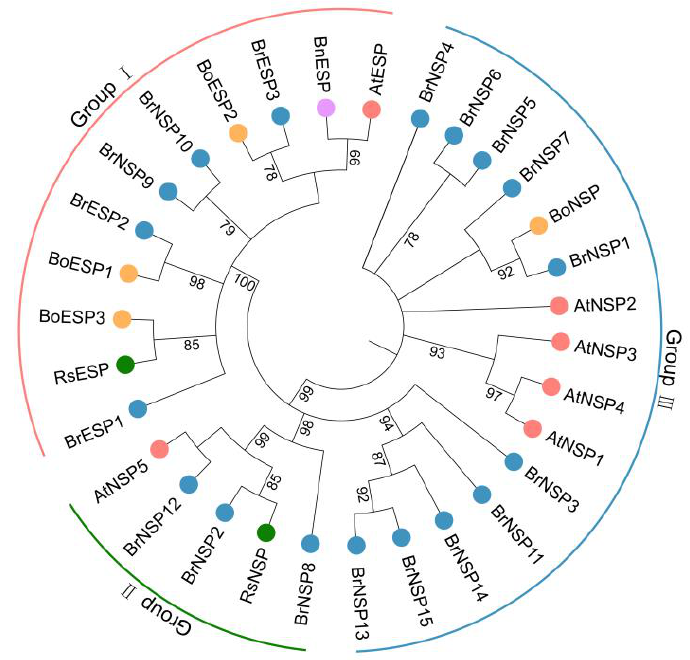
Figure 2. Phylogenetic tree of ESP and NSP proteins from A. thaliana , Chinese cabbage, B. oleracea , B. napus , and R. sativus . The phylogenetic tree was plotted using MEGA7 and the maximum likelihood method with 1000 bootstrap replicates.